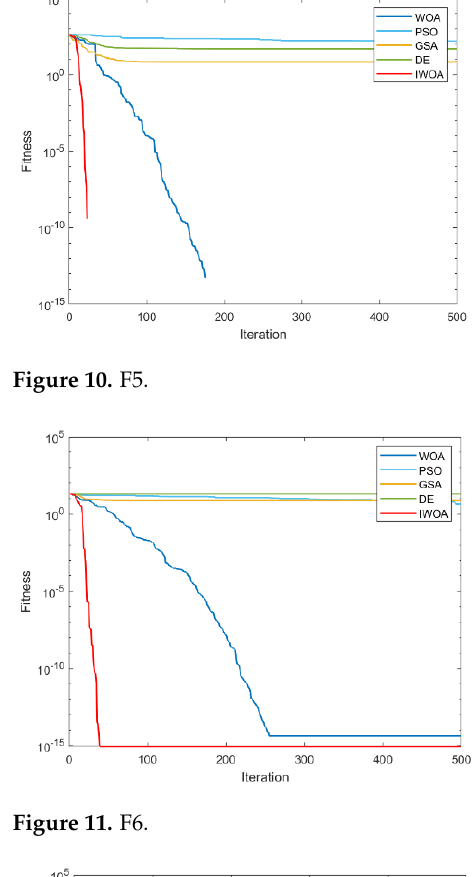
12 of 26 Figure 7. F2. Figure 8. F3.